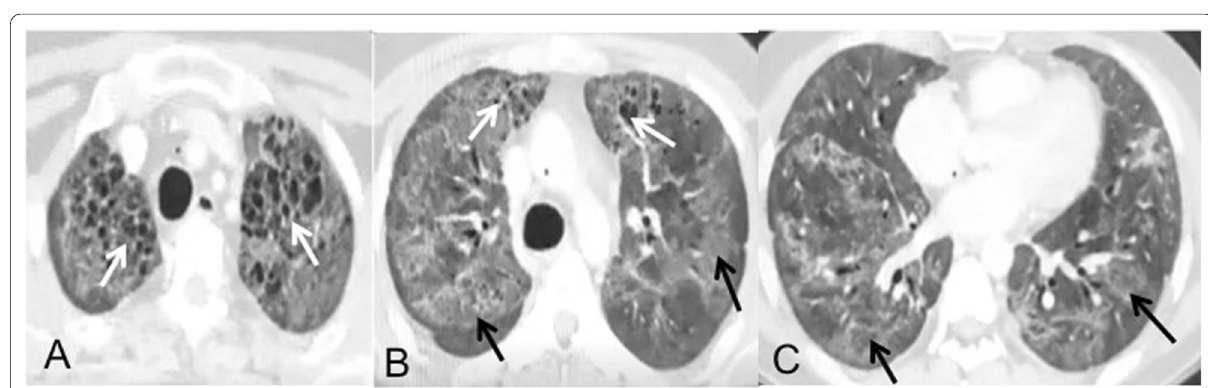
Fig. 4 Bilateral lungs show diffuse ground-glass opacities (black arrows) with diffusely interspersed microcystic changes predominantly located in upper lobes (white